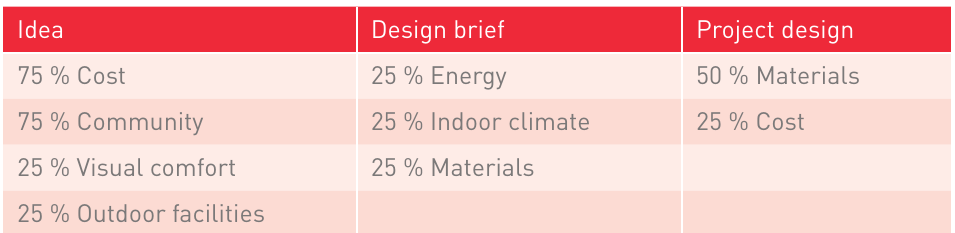
Percentages denotes the frequency of specific parameters mentioned by clients and they representatives.